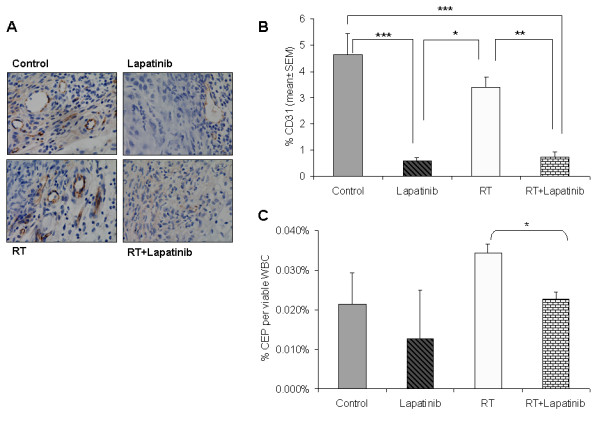
Lapatinib alters angiogenesis and the number of circulating endothelial progenitors (CEPs) in mice xenotransplanted with A549 tumor cells. A. Representative images of CD31-stained tumors from controls, lapatinib-treated, radiotherapy-treated and radiotherapy plus lapatinib-treated mice. B. Lapatinib dramatically reduced the CD31-positive area in the tumors (*: P < 0.05; **: P < 0.01; ***: P < 0.001); C. Quantification of CEPs in A549 tumor-bearing mice by flow cytometry from the peripheral blood. Lapatinib tended to reduce the number of CEPs compared to controls. Interestingly, it significantly diminished the number of CEPs (P = 0.0167) that were increased after radiotherapy treatment.